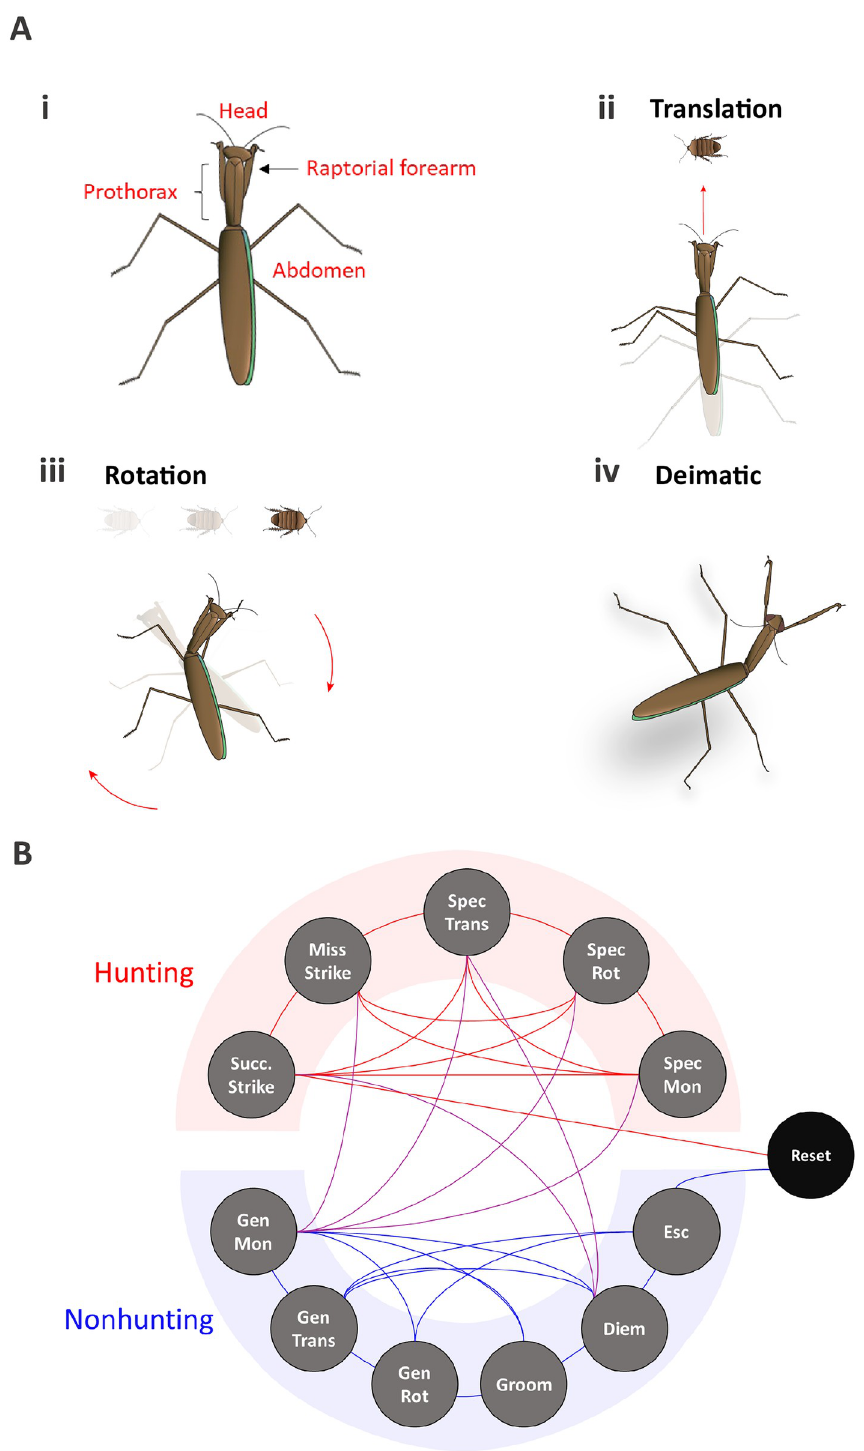
Fig 1. Examples of exhibited behaviors and behavior transitions. (Ai) Anatomical designations that may be references in the text with examples of the behavioral actions of translation (Aii), rotation (Aiii), and deimatic fear response (Aiv). (B) The freely behaving praying mantis can transition between the bins with few experimenter-defined constraints as outlined in the text.